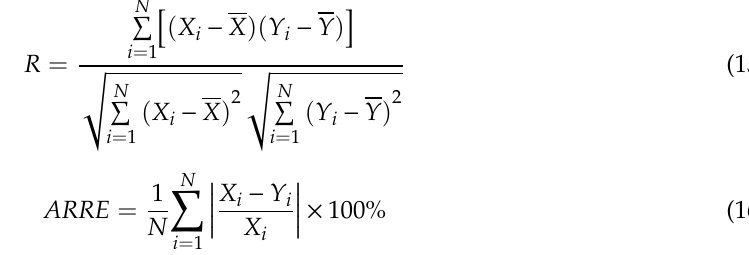
Figure 7. Comparison of theoretical and experimental values of the constitutive equation with strain correction: ( a ) 1273 K, ( b ) 1323 K, ( c ) 1373 K, and ( d ) 1423 K.